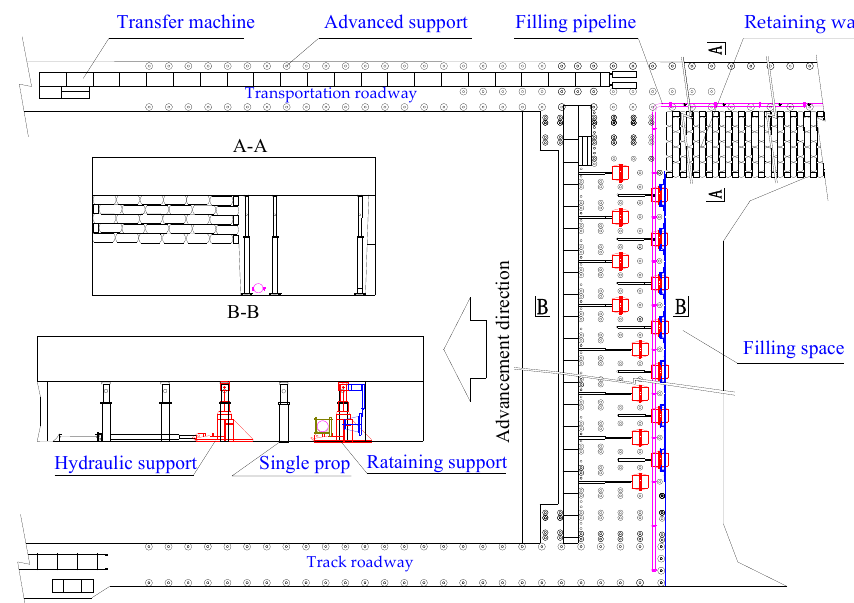
Figure 3. Schematic diagram of the mining method in the backfill mining working face.